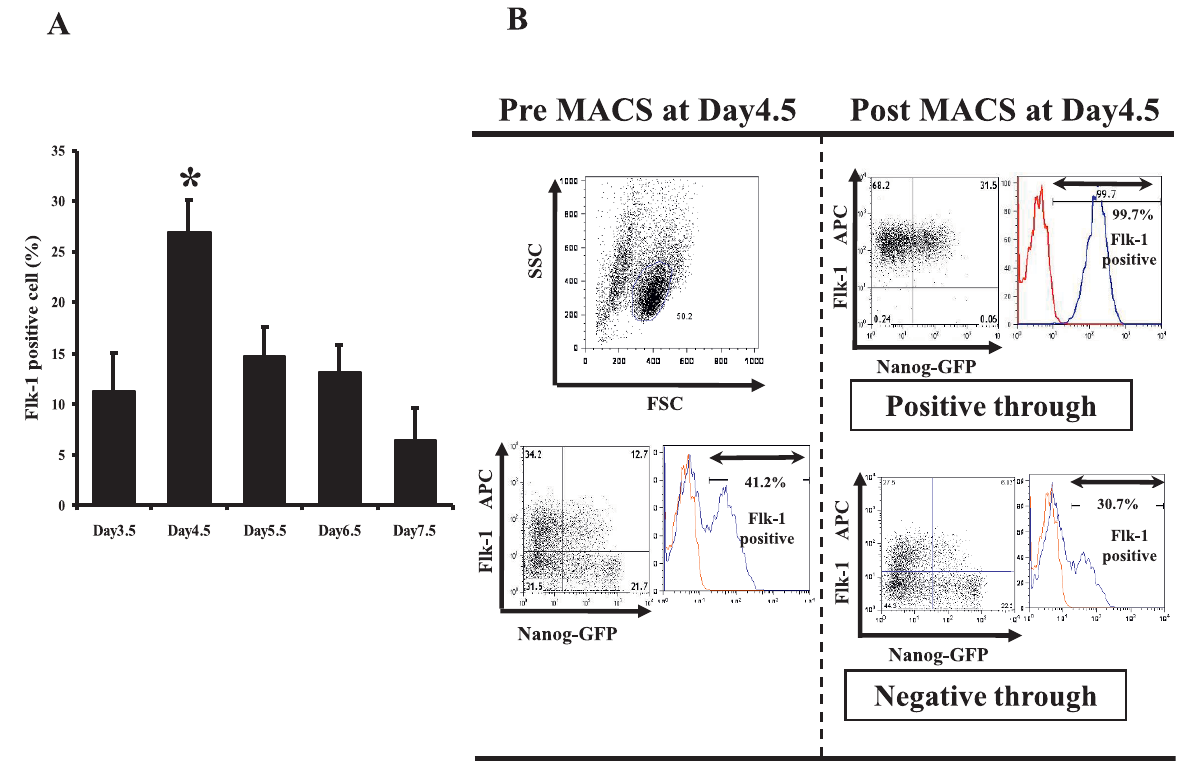
Figure 1 Purification of Flk-1+ cells from iPS cells . A) Flk-1 expression profiles from 3.5 days to 7.5 days of cultivation as determined by flow cytometric analysis. (* p < 0.05 Day4.5 vs Day3.5, 5.5, 6.5 and 7.5). B) FACS analysis of pre and post MACS-sorted Flk-1 + cells at day 4.5.